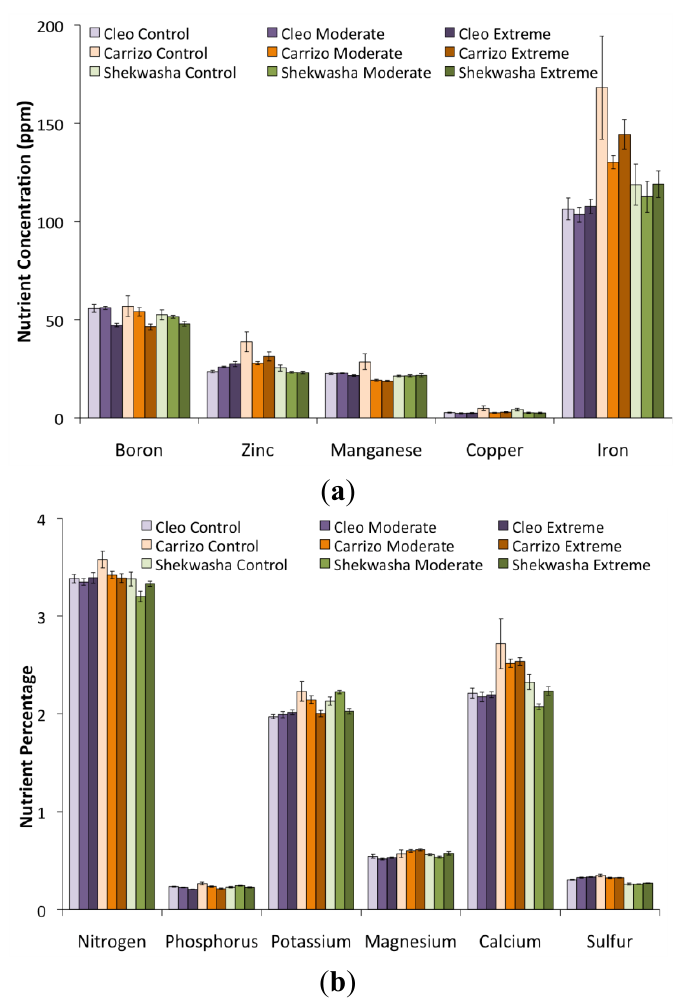
Figure 4. Nutrient concentrations of seedlings following the conclusion of the experiments. ( a ) Concentrations of boron, zinc, manganese, copper and iron in ppm, and ( b ) concentrations of nitrogen, phosphorous, potassium, magnesium, calcium, and sulfur in